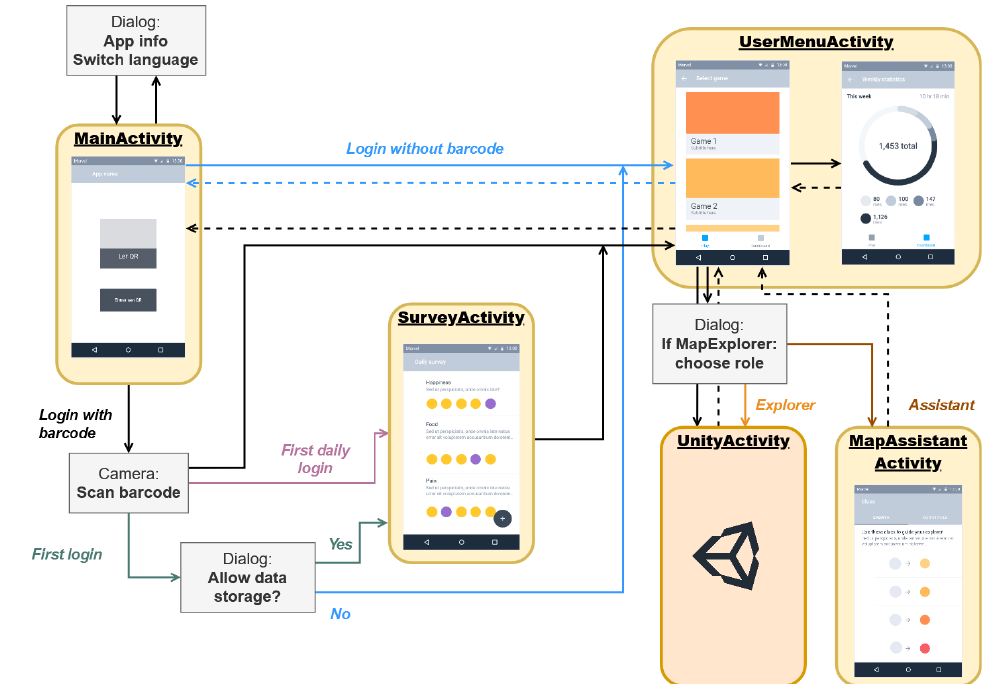
Figure 3. Overview of the mobile application